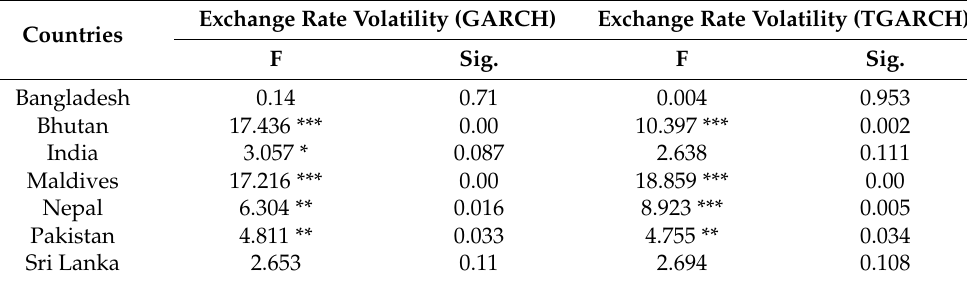
Table A3. Levene’s Test for Equality of Variances (4 Years-Pre & Post 2014).